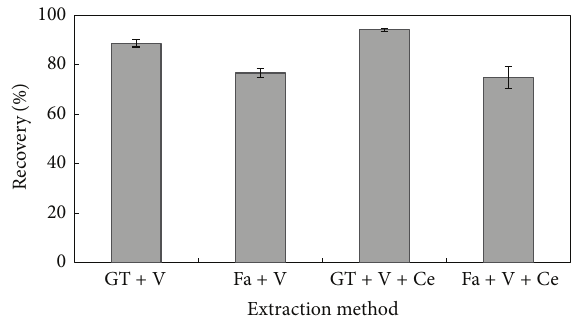
Figure 3: Percent recoveries in four extraction methods (GT: glass tube; V: vortex; Fa: falcon tube; Ce: centrifuge).